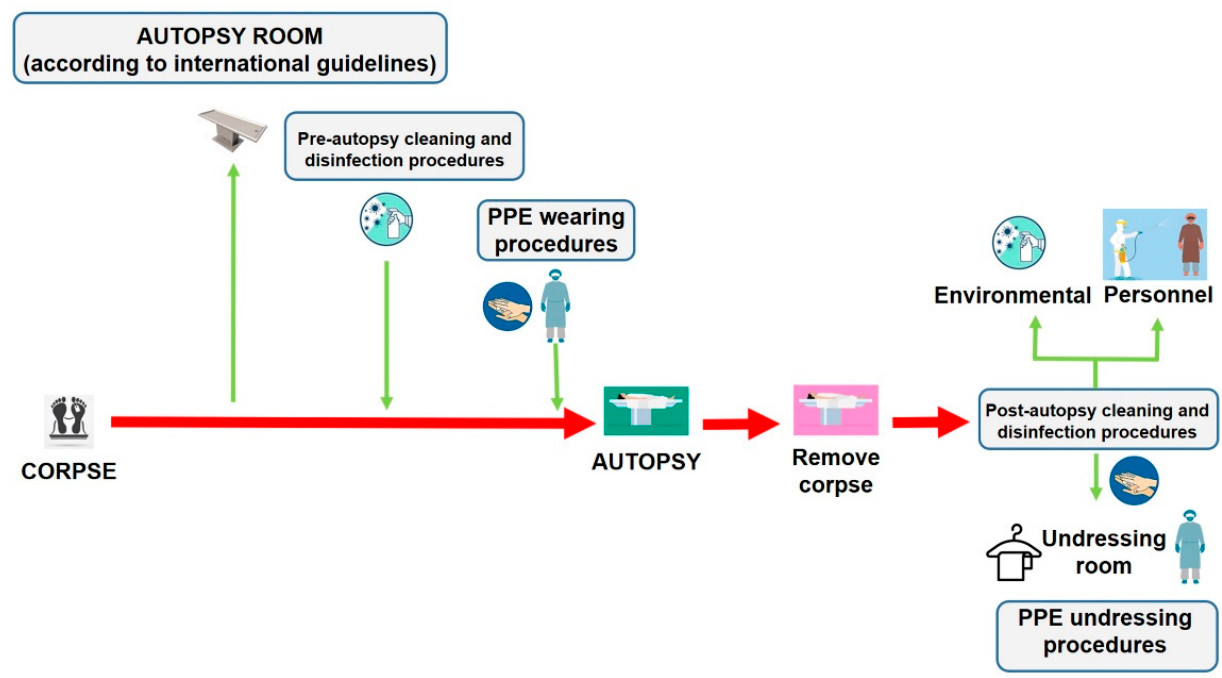
Figure 5. The management of corpses of persons with suspected or confirmed COVID-19 to perform autopsy, should be made following all disinfection procedures described in the current paper. In particular, after removing the corpse, it is necessary to adopt cleaning and disinfection procedures both in the autopsy room and on the personnel involved in the post-mortem investigation before leaving the room, through a nebulization procedure of all PPE products (the personnel is depicted in purple). In this manner, when the personnel (in this case depicted in blue) arrive in the changing area, they perform hand hygiene with specific products, and start the changing procedures in a safe manner.